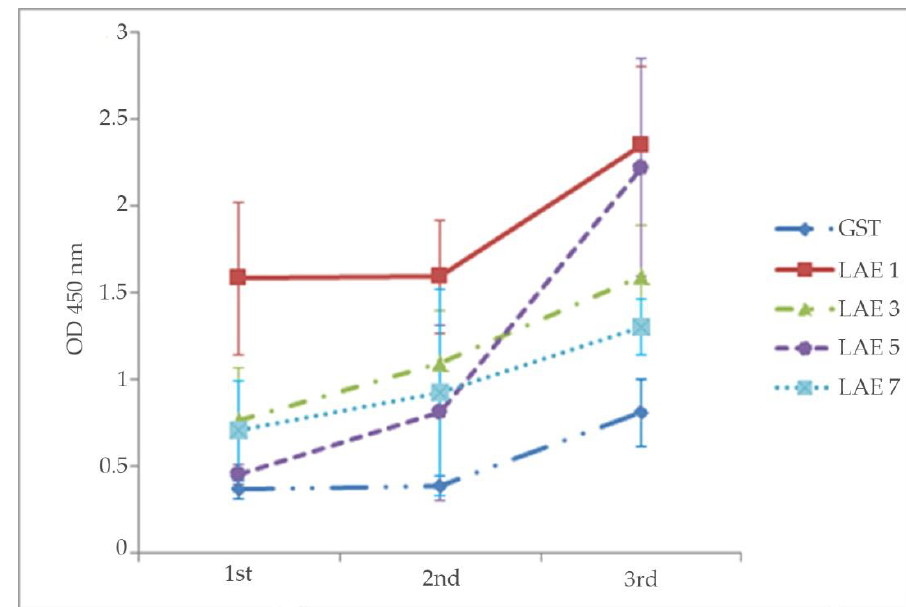
Figure 4. Measurement of rVP1-specific antibody activities in the antisera of mice immunized with the GST-LAE-fusion proteins (LAE1, LAE3, LAE5 and LAE7) by iELISA, using the rVP1 protein as the antigen. The GST-fusion protein antiserum (GST) was used as the negative control. The ordinate indicates absorbance (OD450 nm) of the antisera (abscissa) when reacted against rVP1. Note that there were 4 immunizations done at days 0, 14, 28, and 42; and there were 3 bleedings done at days 14, 28, and 45. 1st = 1st bleed at day 14; 2nd = 2nd bleed at day 28; 3rd = 3rd bleed at day 45. The data are presented as the mean absorbance ± 1 SD (n = sera from the 6 mice in each group).